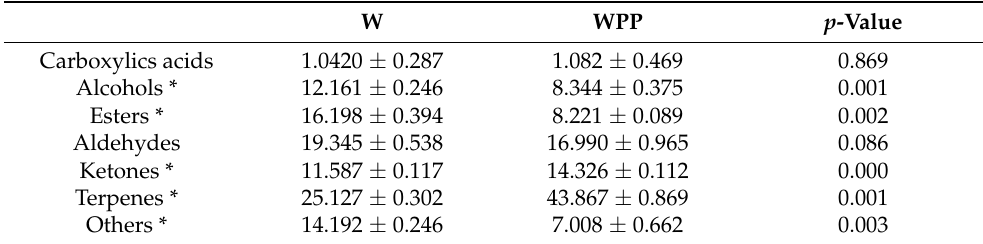
Table 3. Relative abundance (%) of organic compounds in unfermented malt wort (W) and malt wort added with 5% apricot puree (WPP). W WPP p -Value Carboxylics